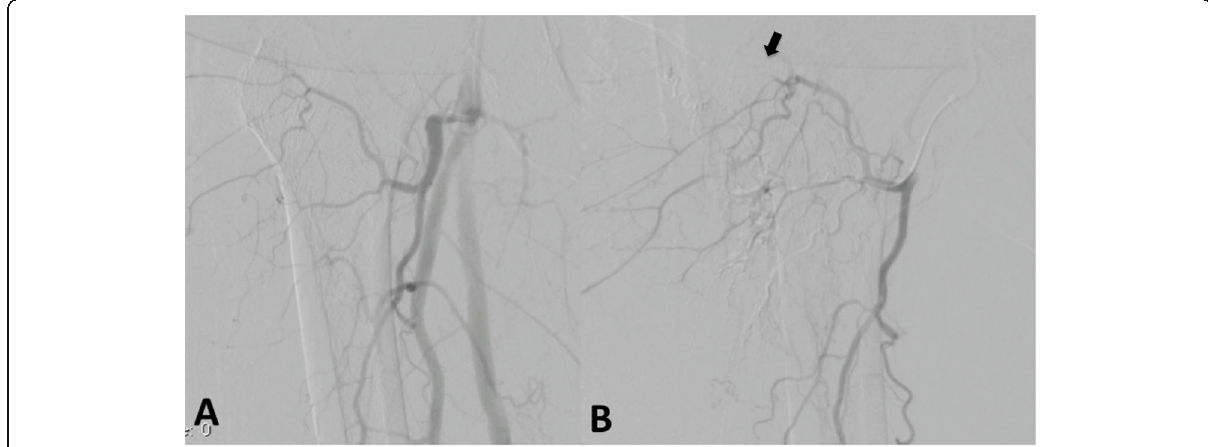
Fig. 3 Pre ( a ) and post ( b ) angiogram of the profunda femoris demonstrating the area of stasis at the more superior branch ascending branch of the lateral femoral circumflex artery